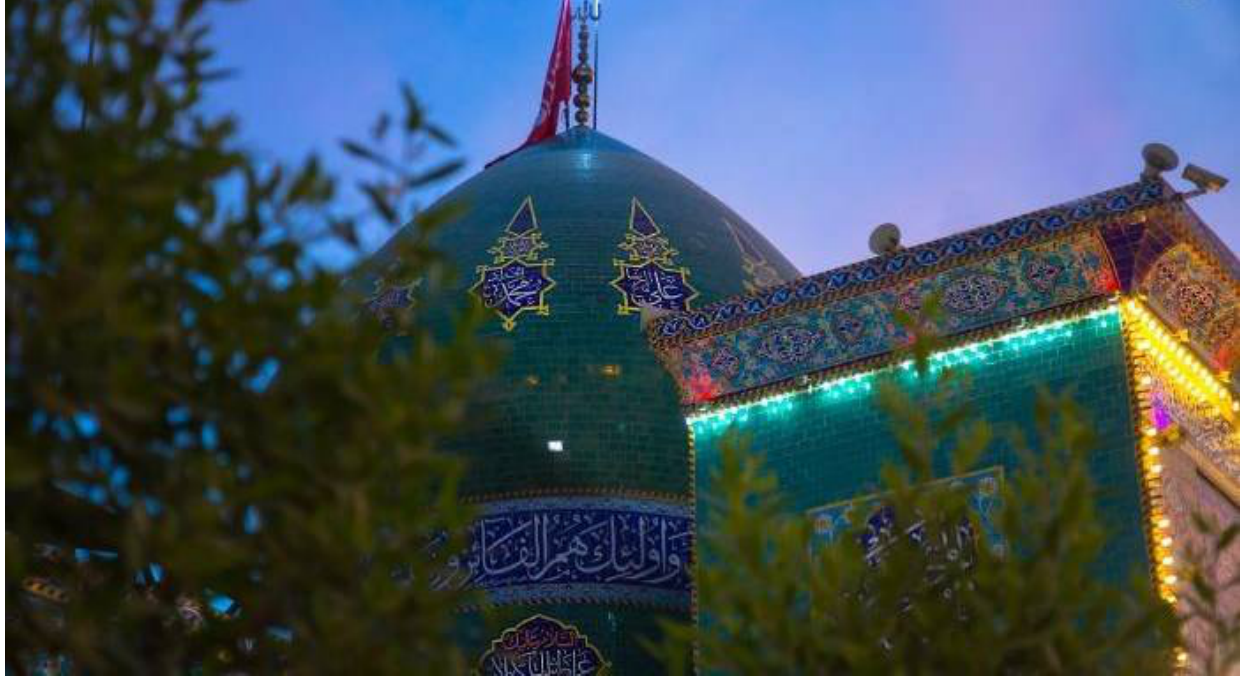
Figure 11. Figure 11. Source: “The Camp of Imam Hussain”, Imam Hussain Holy Shrine (20 May 2018). https://imamhussain.org/ english/karbala/18070. accessed on 1 October